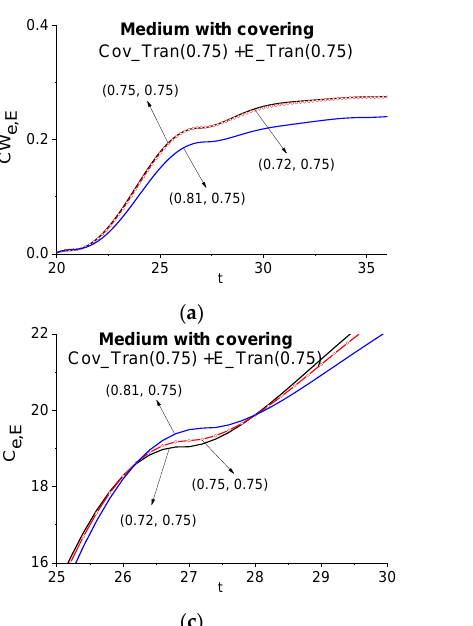
( b ) Figure 9. Time-dependent ICC CW e,E ( a ), CW1 e,E ( b ) calculated at the frequency ν = 0.96 in the time interval t = [20, 36] for the pair of pulses transmitted through the medium with covering (Cov_Tran— a signal under investigation) and without covering (E_Tran—a standard signal). As we see in Figures 6c and 7b, there is an absorption frequency ν = 0.75 in the spectrum of the pulse transmitted through the medium covered by disordered structure. We show that this frequency is a false absorption frequency. With this aim, we use the E_Tran spectral line dynamics at this frequency during the main pulse as a standard one. In Figure 10 the ICC CW e,E evolution is shown at the frequency ν = 0.75 for the Cov_Tran main